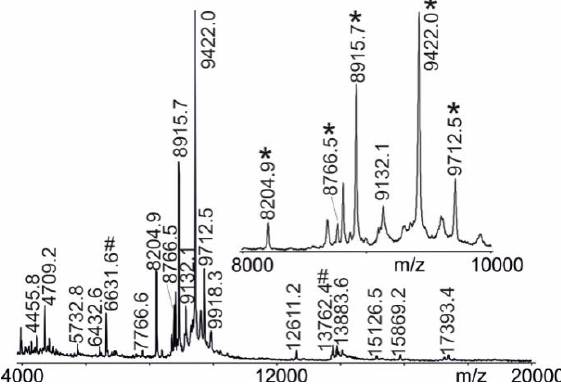
Figure 1. A ffi nity—MALDI-ToF mass spectrum of intact protein ions. Proteins are from maternal peripheral venous blood serum upon work-up with ClinProt ® beads. Ion signals that are selected for multi-parametric analysis are labeled with “*” (see insert). Ion signals that are used for internal re-calibration are marked with “#”. Ferulic acid is used as the